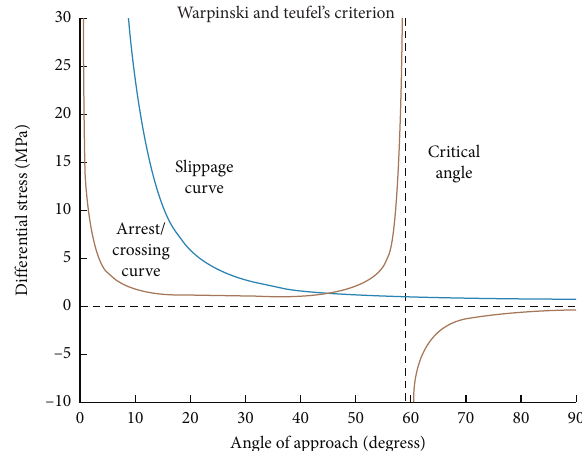
Figure 3: The chart of W&T’s criterion ( p